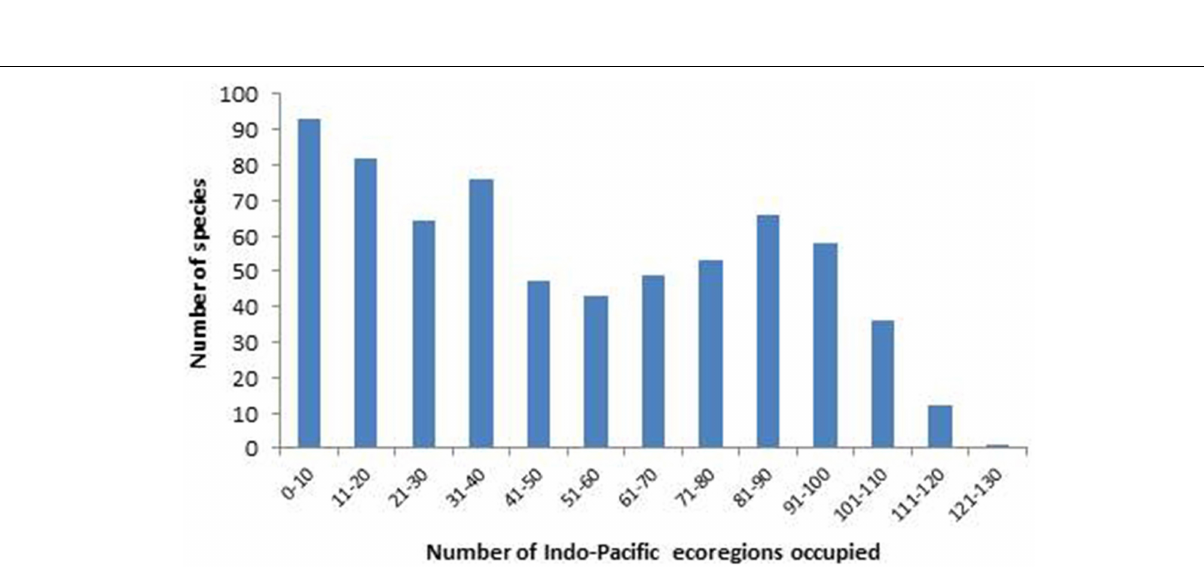
FIGURE 16 | Number of confirmed and strongly predicted Indo-Pacific species in